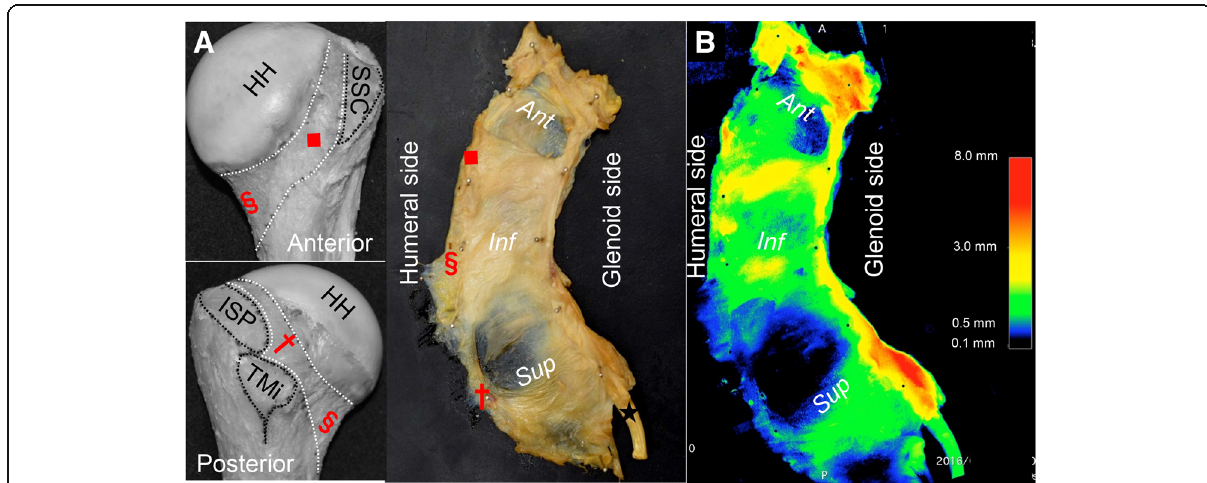
Fig. 6 Analysis of the distribution of the thickness in the whole capsule using micro-CT. After detaching from the glenoid and humerus, the whole capsule, including the biceps labrum complex, was analyzed based on 3D measurement using micro-CT. a Three landmarks of humeral attachment at the inferior edge of subscapularis insertion (red square), most inferior (red section mark), the margin between infraspinatus and teres minor (red cross) are shown in pictures of the humerus. The inside appearance of the whole capsule, including the long head of biceps brachii (black star), which was flattened is also shown. The whole capsule was divided into 3 approximate parts; anterior ( Ant ), inferior ( Inf ), and superior ( Sup ) according to the site of attachment. Three landmarks correspond to each other. b The distribution of thickness on the whole capsule which is shown in ( a ) could be identified in the 3D CT image by micro-CT. The color bar represents the approximate thickness (mm) corresponding to the colors. HH, humeral head; SSC, insertion of subscapularis; TMi, insertion of teres minor; ISP, insertion of